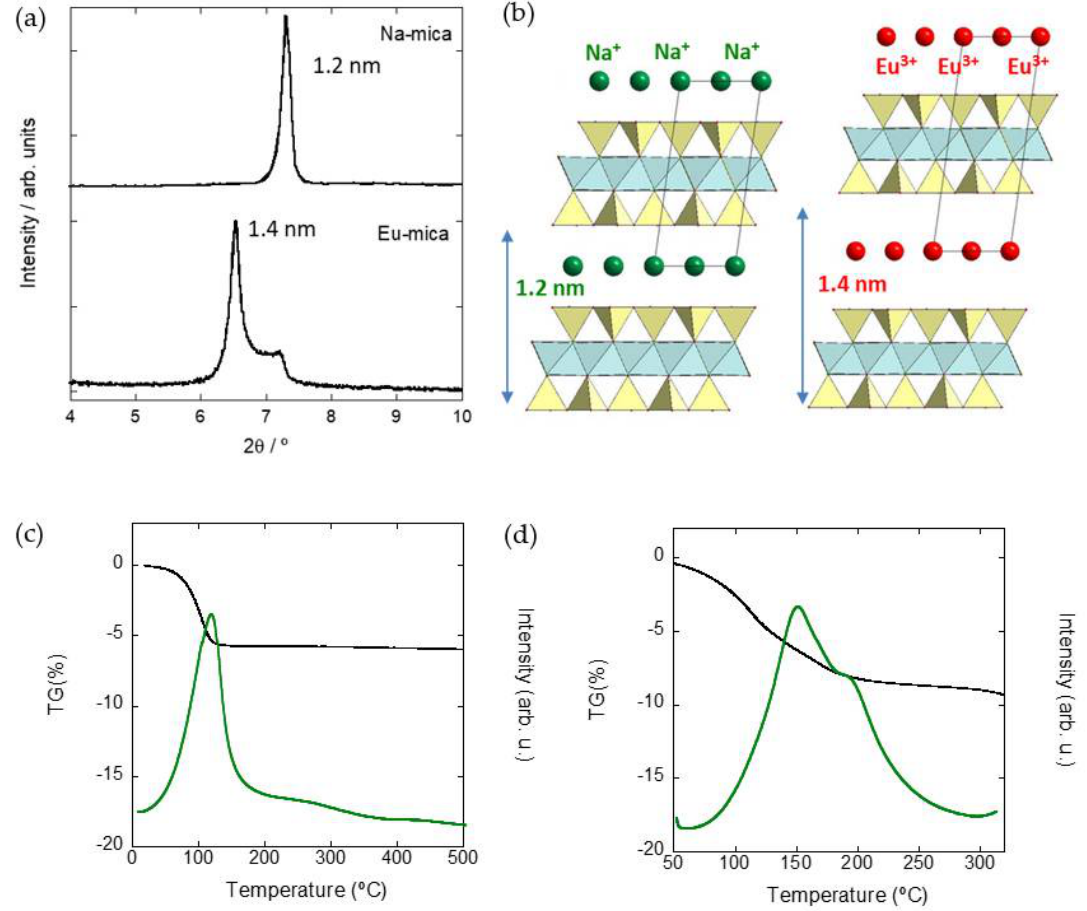
Figure 4. XRD pattern of Na-Mica-4 and Eu 3+ -doped Mica-4 ( a ) and schematic representation of Mica-4 with Na + cations and Eu 3+ cations in the interlayer space, respectively ( b ). TG (solid line), MS H 2 O curve (green) of Na + -Mica-4 ( c ) and Eu 3+ -Mica-4 ( d ).